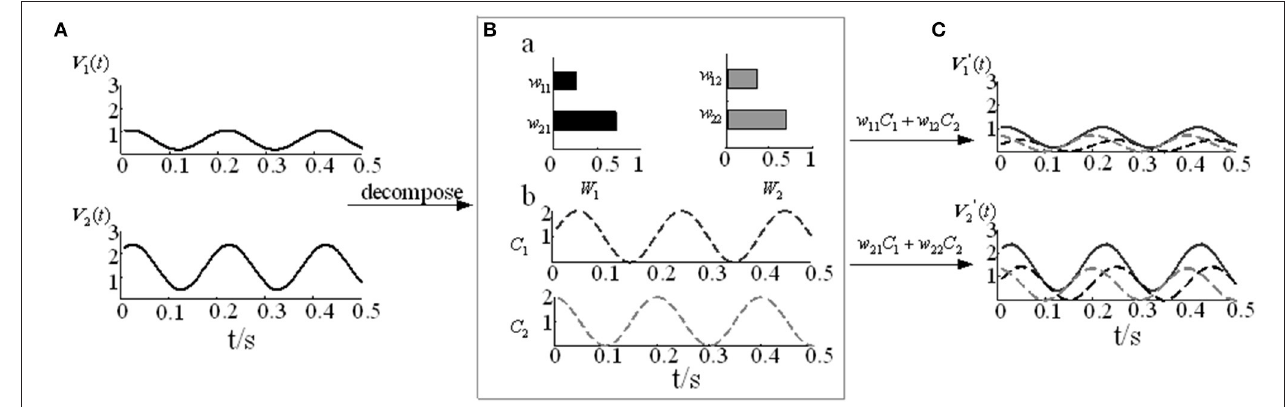
FIGURE 3 | The NMF decomposition model. (A) Two-channel EMG signals V 1 and V 2 . (B) The muscle activation model. (B-a) Muscle synergy vector matrices W 1 and W 2 . (B-b) Time-varying coefficients C 1 and C 2 . (C) Reconstruction signals V ′ 1 and V ′ 2